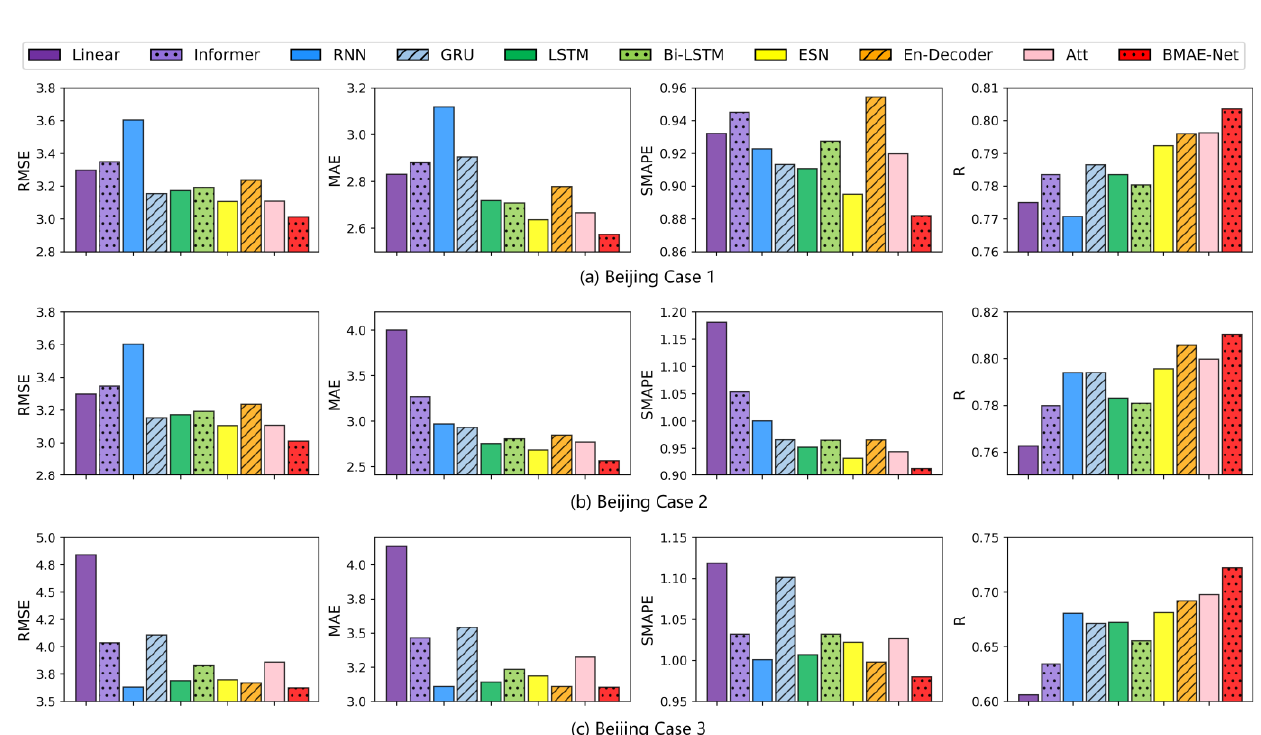
Figure 6. Bar graph of the temperature forecast evaluation index for the Beijing station. Table 4. Experimental results for temperature from the Beijing station.